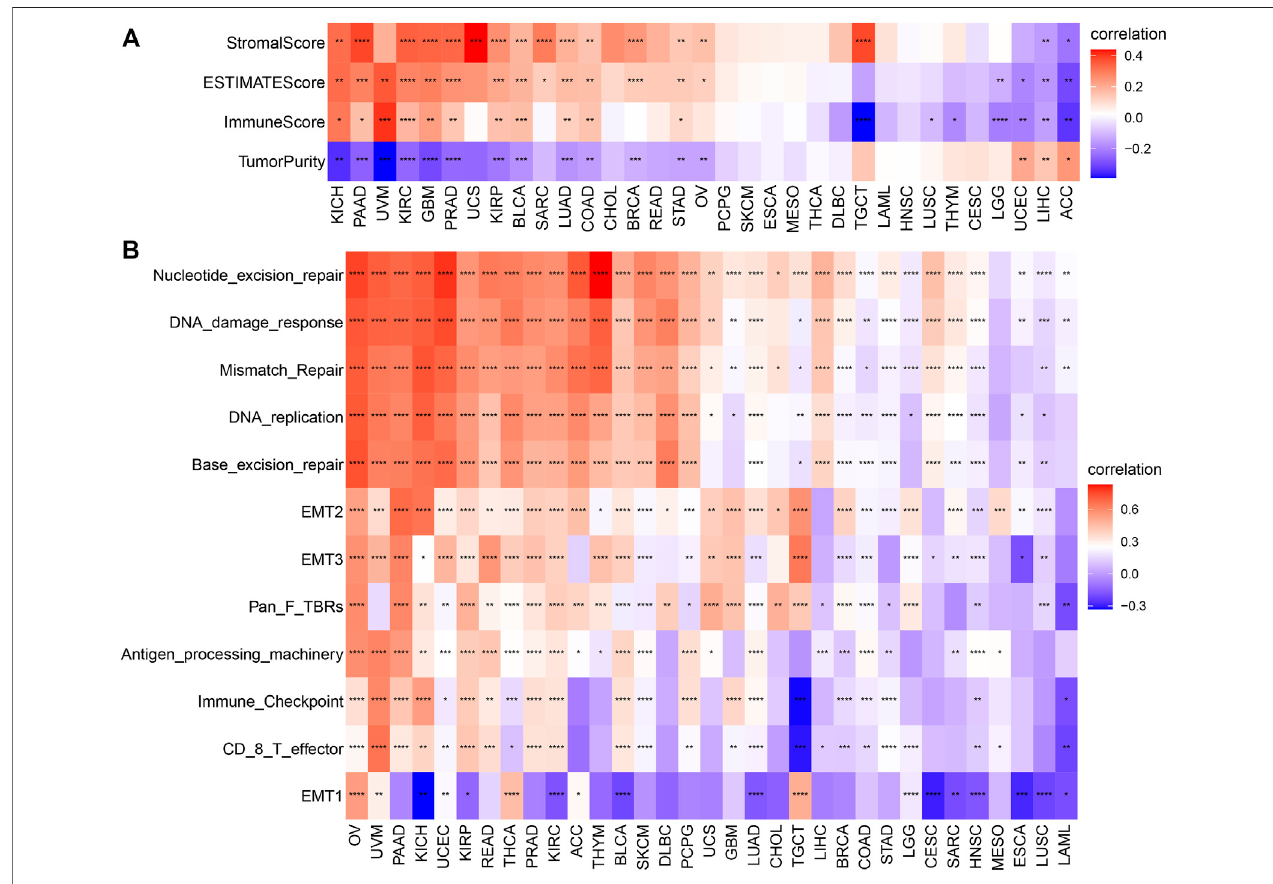
FIGURE 8 | The relationship between AP3S1 and the regulation of the tumour microenvironment. (A) Heatmap represents the correlation between AP3S1 expression andTMEscoresinpan-cancer. (B) TherelationshipbetweenAP3S1andthetumourmicroenvironment.Redrepresentspositivecorrelation,blue represents negative correlation, and the darker the color, the stronger the correlation. * p < 0.05, ** p < 0.01, *** p < 0.001, **** p < 0.0001.